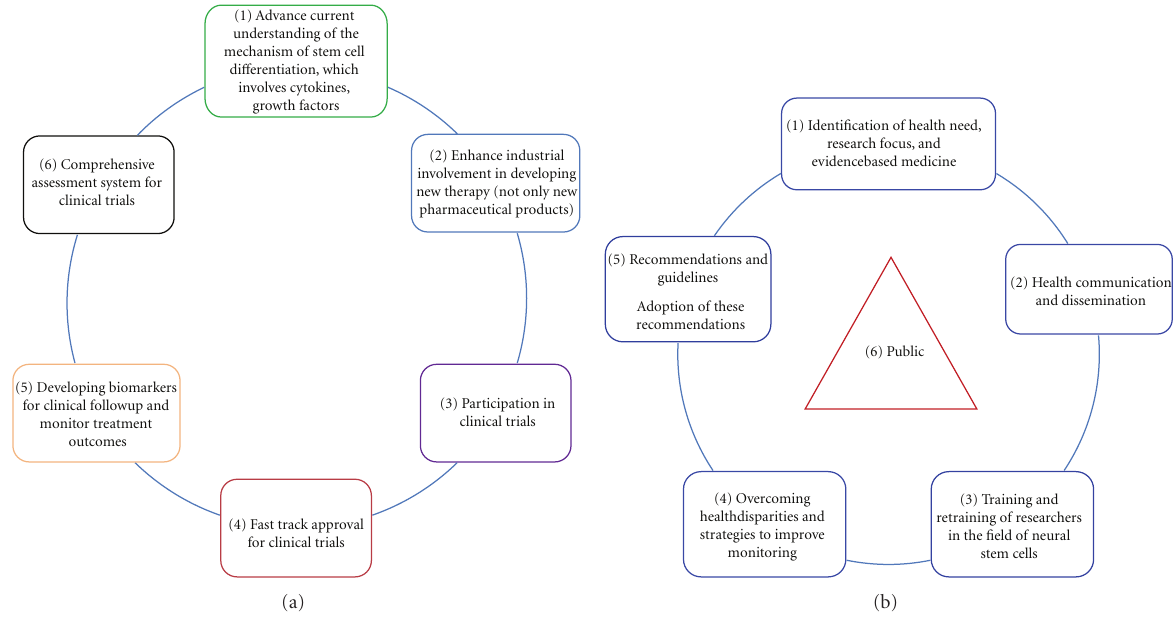
Figure 3: (a) Proposed schema for e ff ective translation involving concerted e ff ort of multilevel strategies of six main stakeholders. (b) Proposed framework for the reinforcement of the multi-level strategies e ff ective bench to bedside translation of NSCs in TBI. The intent to treat models, di ff erences in statistical